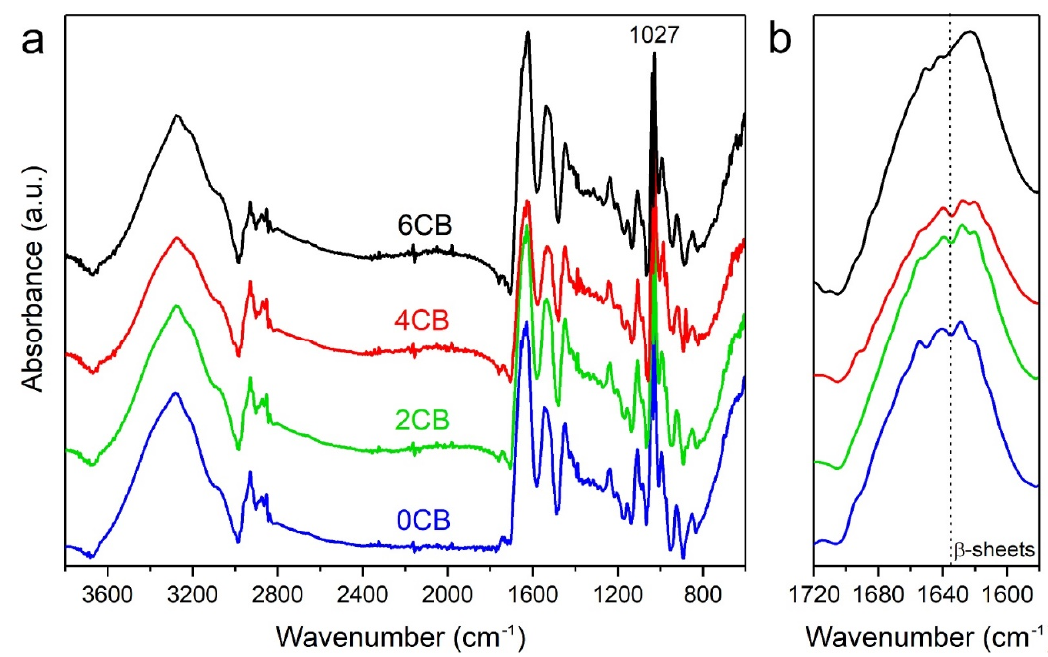
Figure 5. Fourier transform-infrared (FT-IR) spectra of gluten / CB biocomposites: ( a ) entire spectra and ( b ) enlarged amide region.